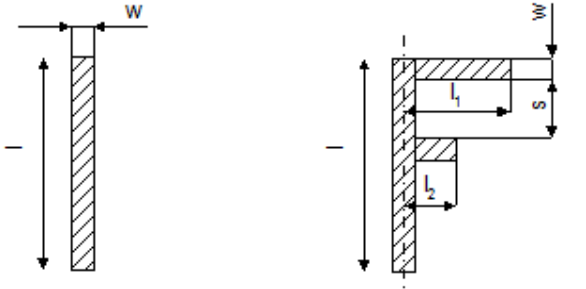
Figure 1. Topology and dimensions of the two studied antenna designs (on the left a dipole; on the right an F-antenna). right an